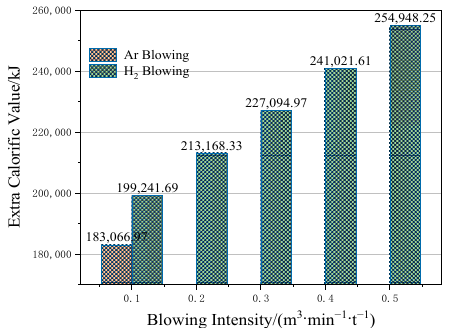
Figure 2. The extra calorific value generated in the 210 t converter for hydrogen bottom blowing at different intensities.